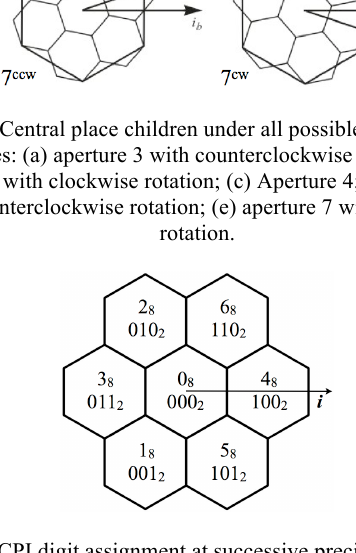
Figure 3. CPI digit assignment at successive precisions, defined relative to the i -axis at that